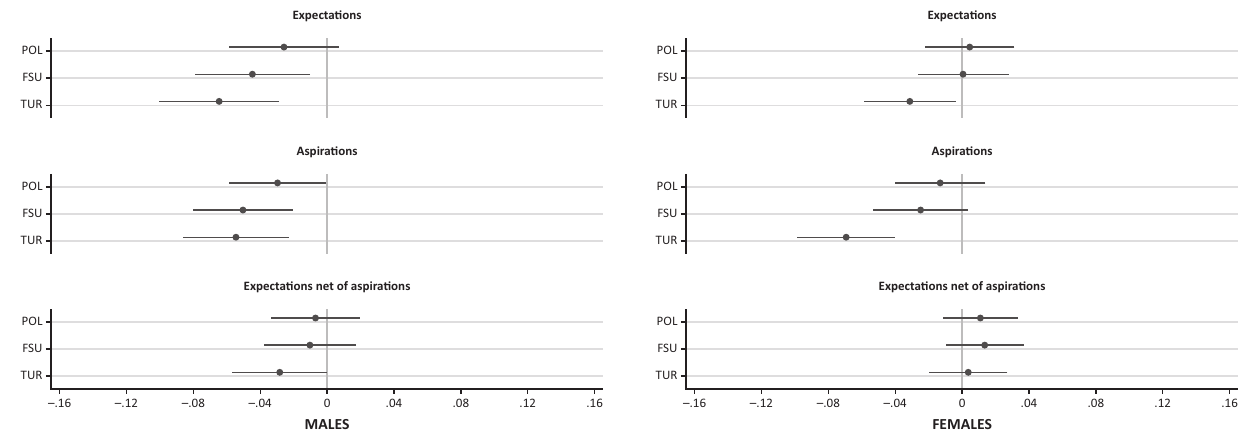
Figure 1. Differences in GTOO by country of origin (ref. Germans) for the male and female samples. Notes: Linear random intercept models; 95% confidence interval; N(males) = 4,868; N(females) = 5,396; N(schools‐males) = 608; N(schools‐females) = 610. Higher values of GTOO refer to a higher same‐sex share in respective occupations. Controls: